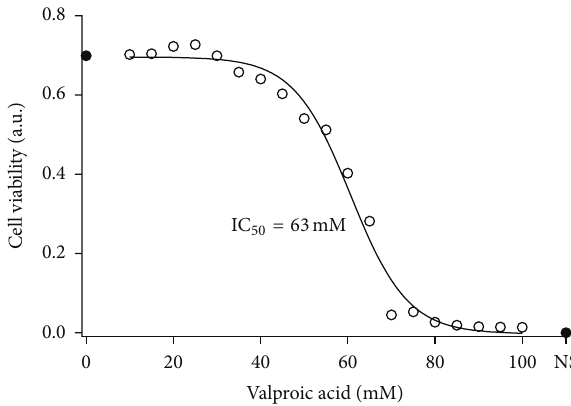
Figure 5: Dose response of the viability of BxPC3 cells to various concentrations of valproate-sodium to determine IC 50 of the drug. Note that (Zn, Al)-LDH nanoparticles were not used for drug delivery for this